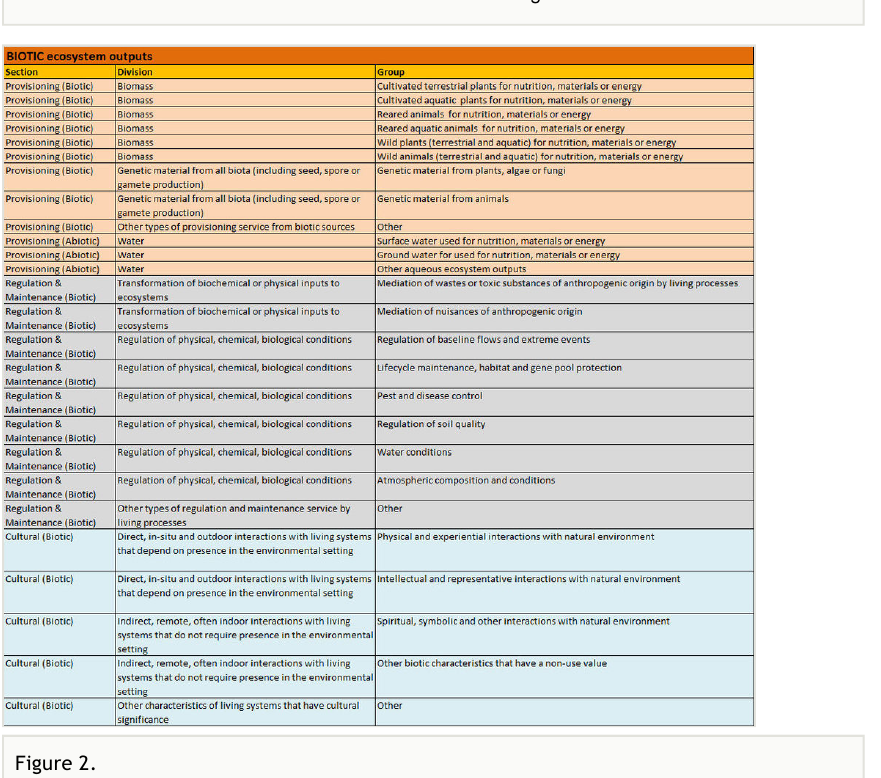
Figure 1. Illustration of the hierarchical structure of CICES V5.1 using cereals.